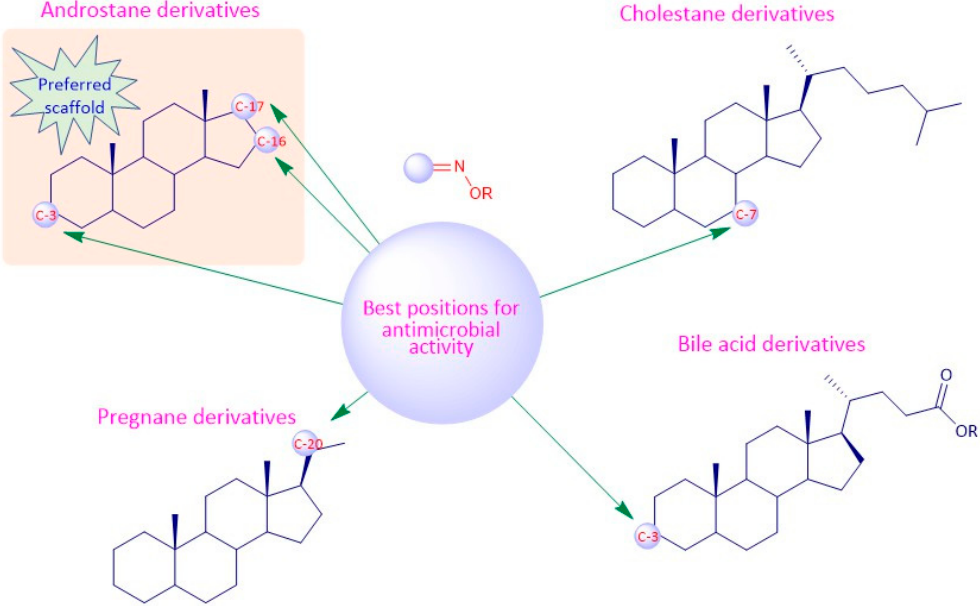
Figure 21. Most common SAR of steroidal oximes with antimicrobial activity.